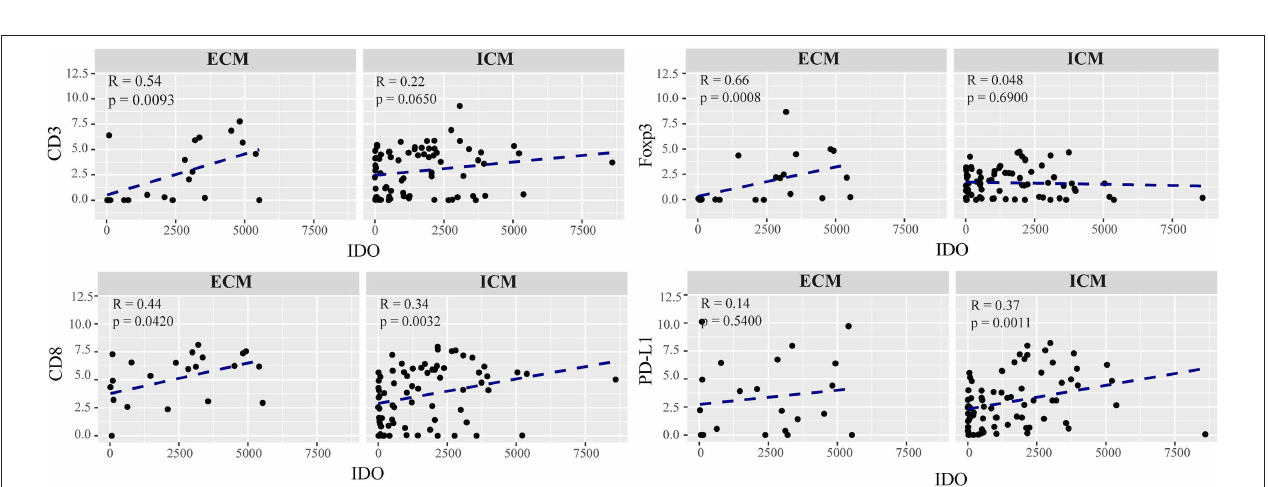
FIGURE 5 | Correlation of the immunoreactive infiltrate and IDO expression in extracranial and intracranial melanoma metastases. Each dot in the scatter plot represents an individual patient. The x-axis represents the total number of IDO expressing cells and the y-axis shows the expression of CD3, FoxP3, CD8, and PD-L1 represented in a logarithmic scale. ECM and ICM denotes the exracranial and intracranial melanoma metastases. Spearman correlations were performed and regression was calculted using ( lm )